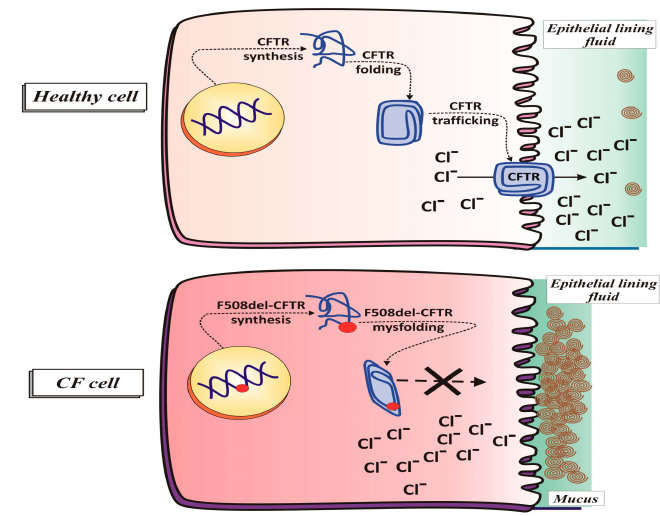
Figure 1. CFTR activity in the cell. In a HEALTHY CELL , a correct insertion of normal CFTR on the membrane allows for the ion movement across airway epithelium; in a CF CELL , transport Cl − ions does not occur due to the mutated-CFTR channel protein (F508del-) inability for reaching the plasma membrane.